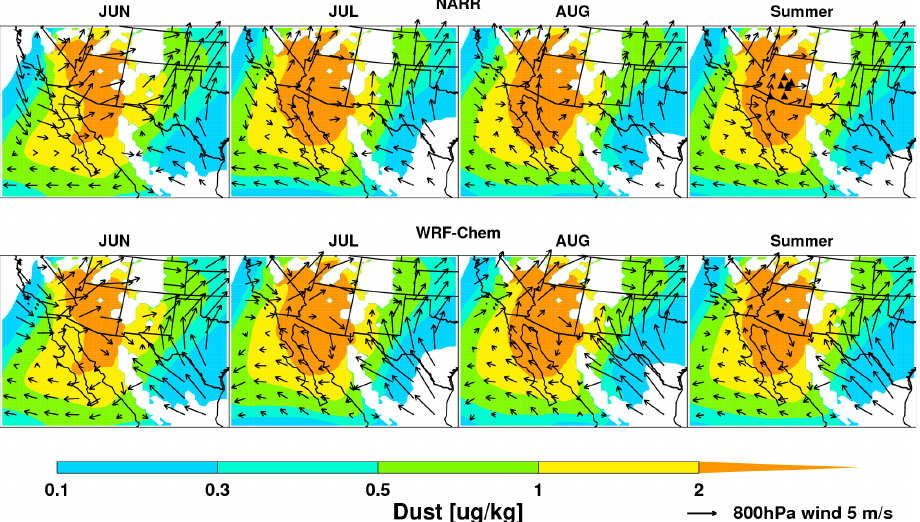
Fig. 2. Spatial distributions of wind over the NAM region from NARR reanalysis data and WRF-Chem simulations and dust concentrations from WRF-Chem simulations at 800hPa in June, July, August, and summer averaged for 1995–2009. The seven upward black triangles (rightmost of the top panel) represent the IMPROVE sites; the one downward black triangle (rightmost of the bottom panel) represents the AERONET site Maricopa in Arizona.